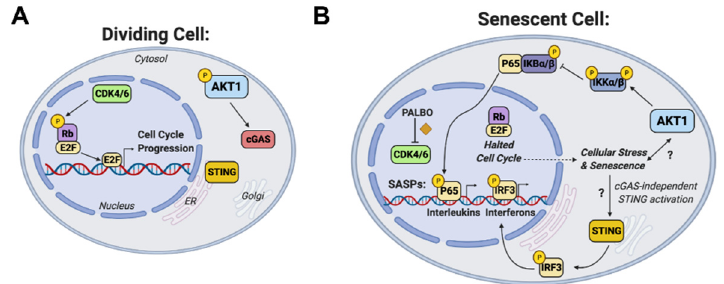
Figure 5. Scheme of role of AKT1 in regulation of senescence, cGAS-STING, and IKK function. ( A ) Dividing cell in which CDK4/6 phosphorylation of Rb contributes to E2F-mediated cell cycle progression, and AKT1 promotes cGAS expression. ( B ) Senescent cell in which Palbociclib (PALBO) inhibits CDK4/6, halting cellular proliferation and contributing to cellular stress and the senescence response through AKT1-mediated NFkB action and cGAS-independent STING activity. Previously undefined abbreviations: CDK = cyclin dependent kinase, Rb = retinoblastoma protein, E2F = E2 transcription factor, ER = endoplasmic reticulum.